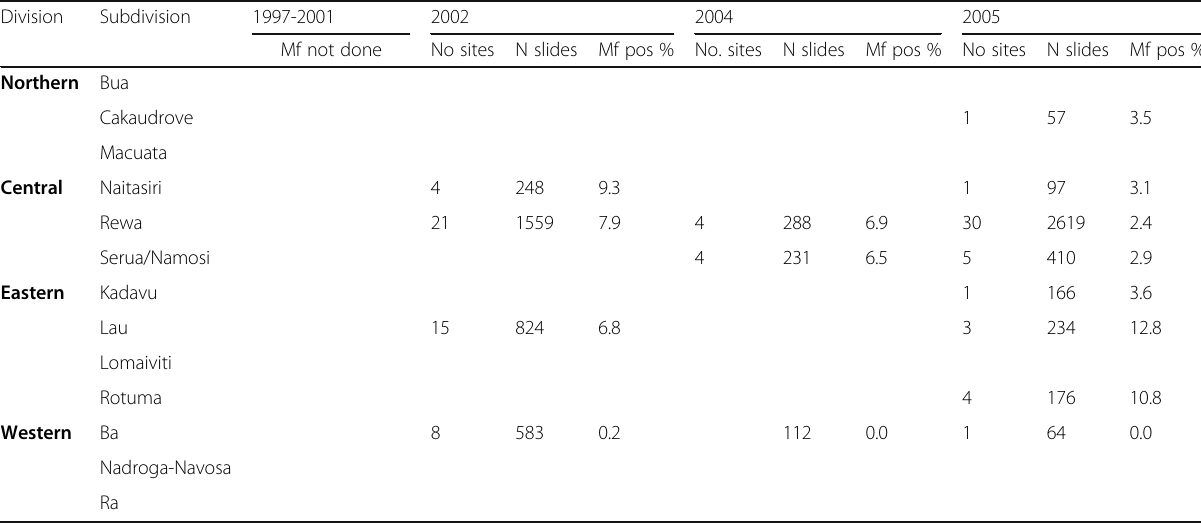
Table 6 sentinel site survey Mf results by division and subdivision Division